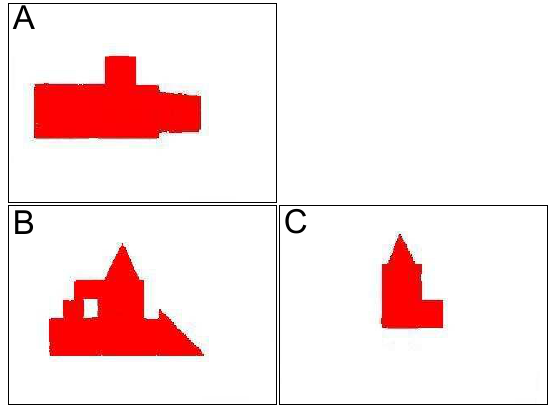
Figure 11. Preprocessed images of first building “I”, ( A )—top side, ( B )—front side, ( C )—right side.